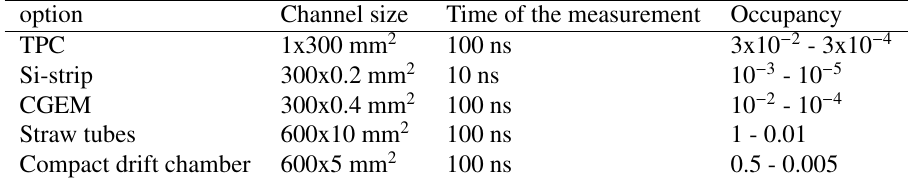
Table 1. Occupancy (fraction of time, when system is busy) for di ff erent options of the Inner